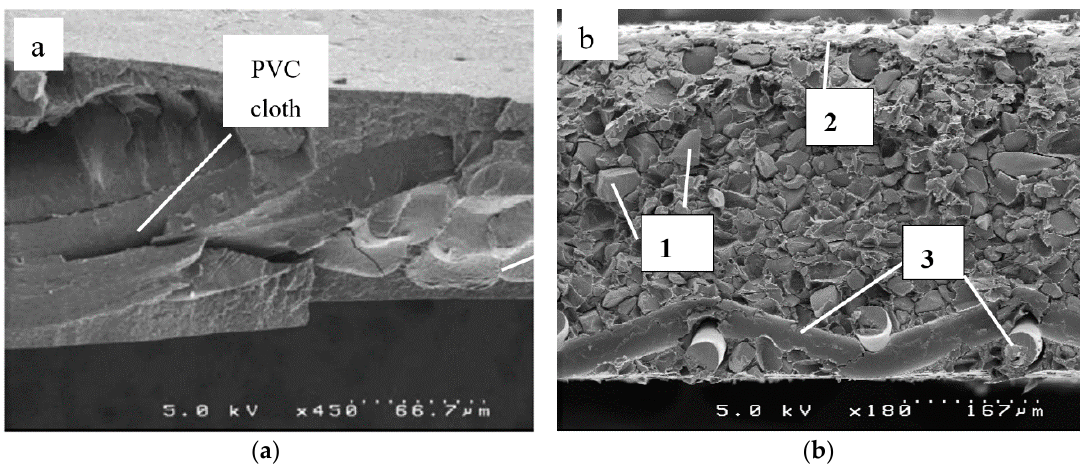
Figure 1. SEM images of surface and cross-sections of IEMs; ( a ) a homogeneous Neosepta ® AMX (Astom, Toukyouto, Japan, 2016) AEM, a styrene-DVB copolymer [12], ( b ) a heterogeneous MA-40 (Shchekinoazot, Russia, 2016) AEM; 1: particles of ion-exchange resin; 2: polyethylene; 3: reinforcing cloth. Reproduced with permission from [4], Wiley, 2012.